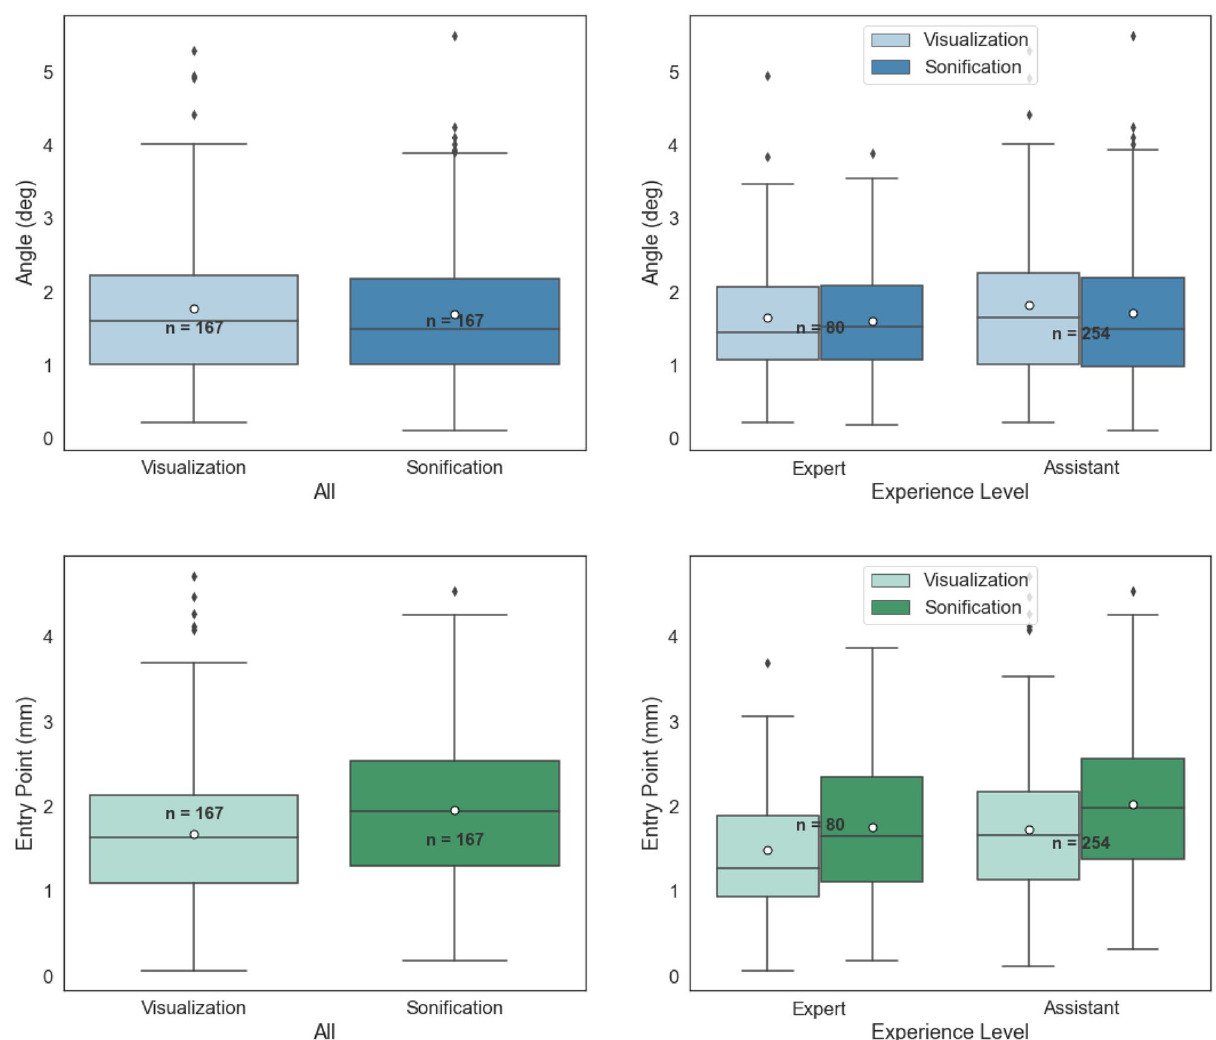
Figure 5. The mean (CT) error of angle (Top), entry point (Bottom) over expertise groups. The white dots in the middle of box plots represent the mean.